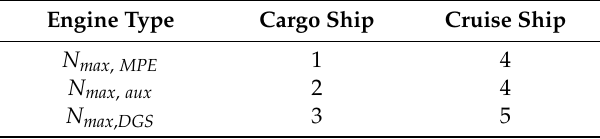
Table 1. Maximum number of installed